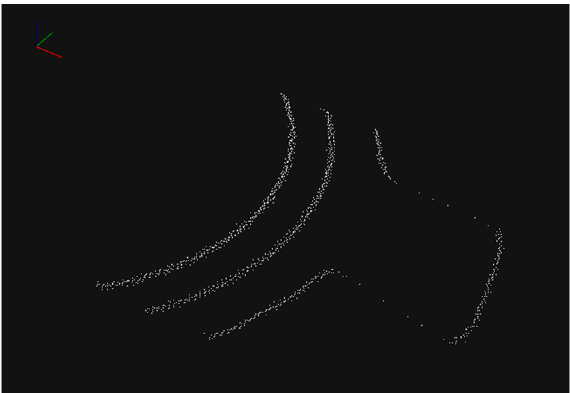
Figure 5. Rendering of negative obstacle point cloud after denoising.